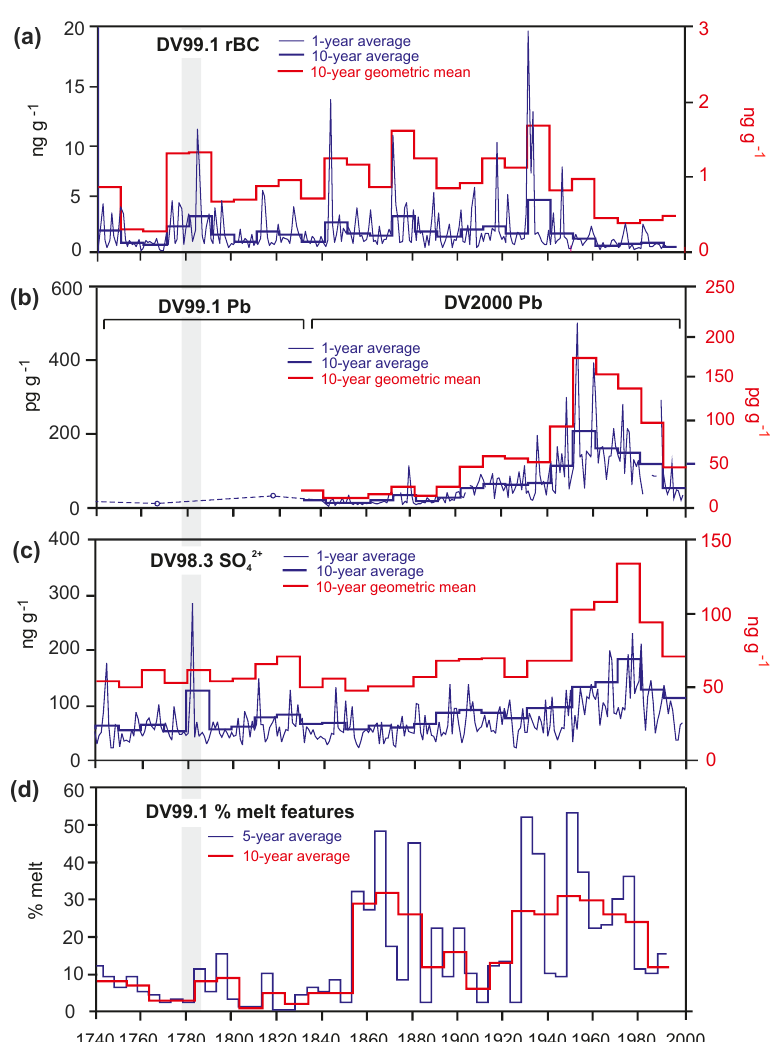
Figure 4. Environmental changes on Devon ice cap, 1740–1999, recorded in three cores from the summit region (DV98.3, DV99.1, and DV2000). (a) rBC concentrations in the DV99.1 core; (b) Pb concentrations in the DV99.1 core ( ∼ 1740–1840) and DV2000 core (1840– 2000); (c) SO 2 − in the DV98.3 core; and (d) volumetric percentage of icy melt features in the DV99.1 core due to surface summer melt. Data 4 are presented in ∼ 1-year, 5-year and/or 10-year averages. For panels (a) to (c) , 10-year geometric mean values of the data are also plotted in red on separate scales (right). The shaded grey bar identifies the Laki 1783 isochron used to correlate the different cores. The width of the bar denotes the maximum dating uncertainty at the corresponding depths in these cores. The Pb data are from Shotyk et al. (2005) and Zheng et al. (2007), the SO 2 − data are from Kinnard et al. (2006), and the melt feature data are from Fisher et al. 4